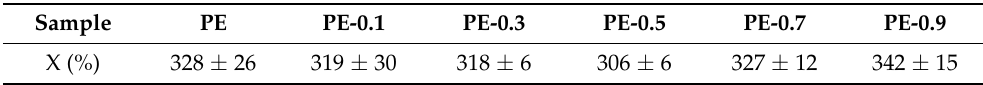
Table 3. Initial elongation at break of PE/Fe-MMT